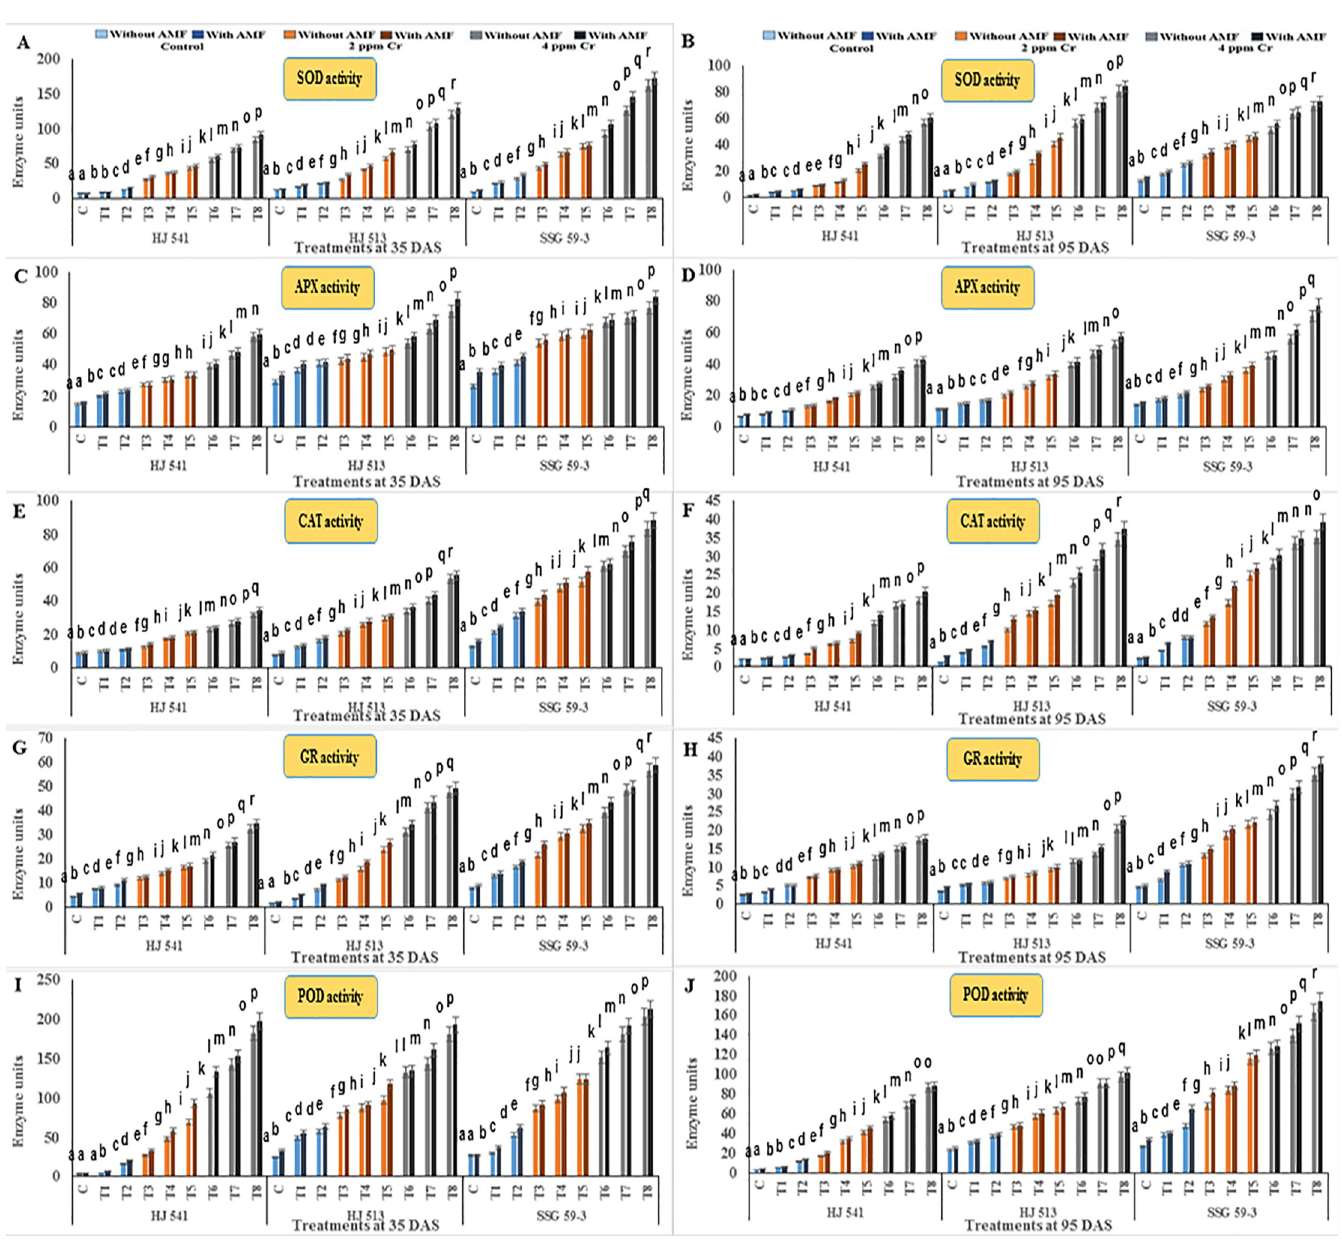
Fig 4. Effects on activities of antioxidant enzymes viz . SOD (A and B), APX (C and D), CAT (E and F), GR (G and H) and POD (I and J) in different varieties of sorghum exposed to GB and AMF treatments under Cr toxicity at 35 & 95 DAS, respectively. Data are expressed as means of three replications with ± S.E., N = 3, from three independent experiments. Different letters above the bars in each column indicate significant differences among treatment means based on the least significant difference (LSD) test at P � 0.05.